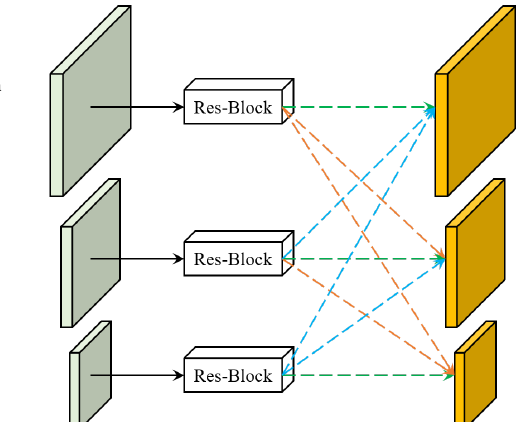
Figure 10. The pipeline of residual-like iteration. Note that n = 3 in this paper.